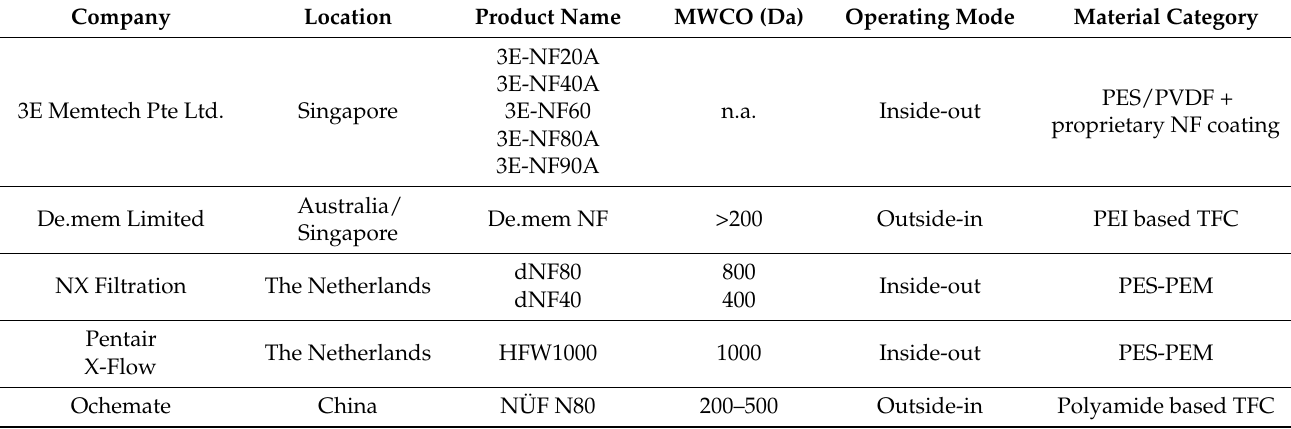
Table 1. HF NF membrane suppliers